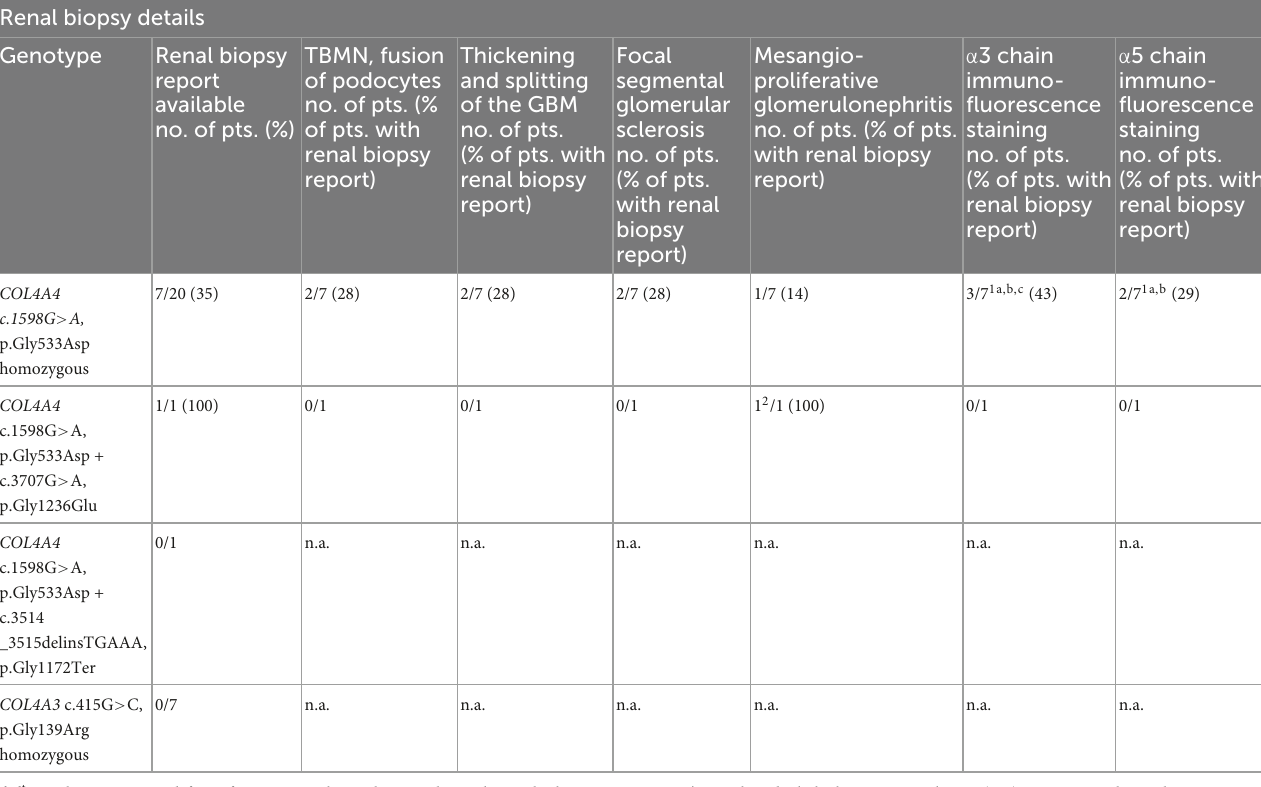
TABLE 4 Summary of renal biopsy histology and α 3, α 5 chain immunofluorescence staining in patients with autosomal recessive Alport syndrome with respect to the genotype. Renal biopsy details Genotype Renal biopsy